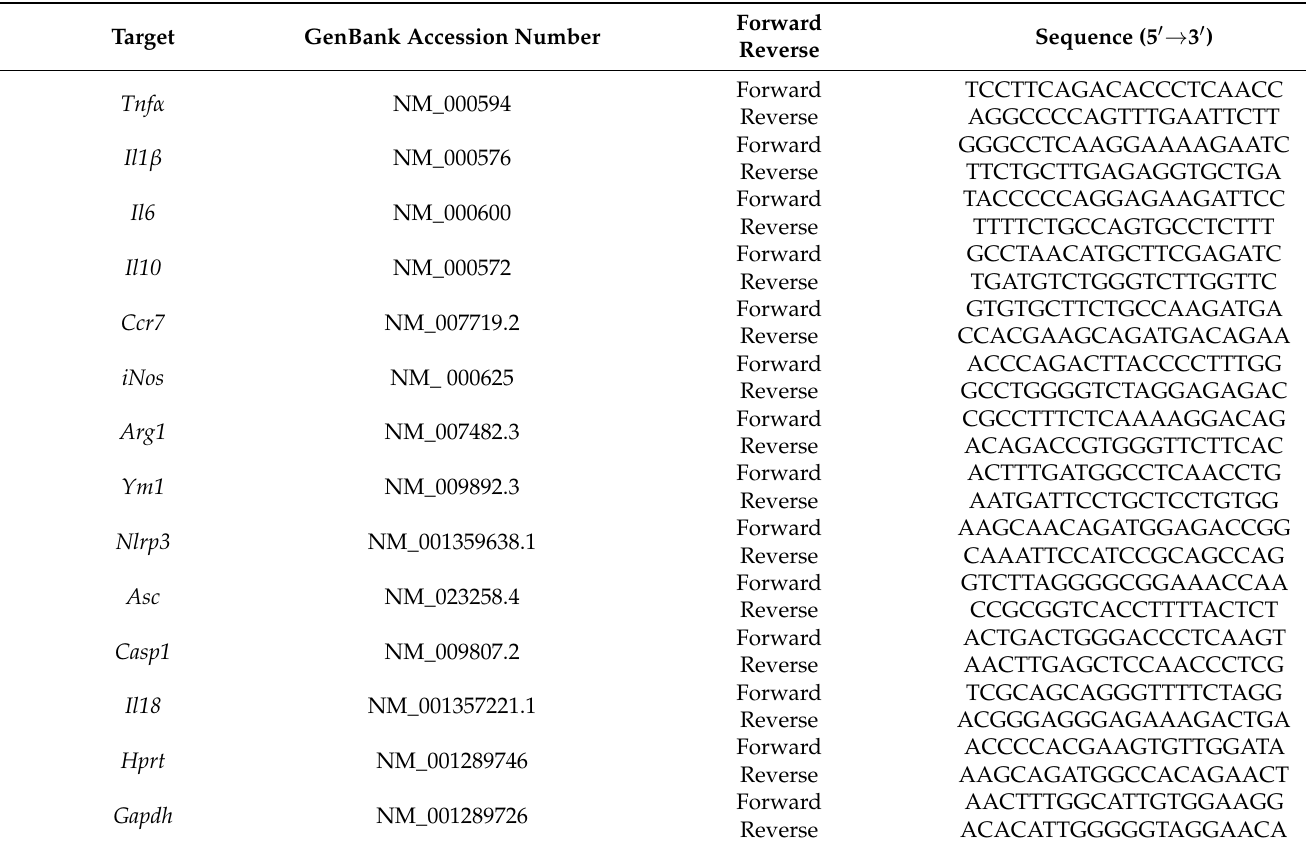
Table 1. Sequence and GenBank accession numbers of oligonucleotides used in RT-qPCR. Target GenBank Accession Number